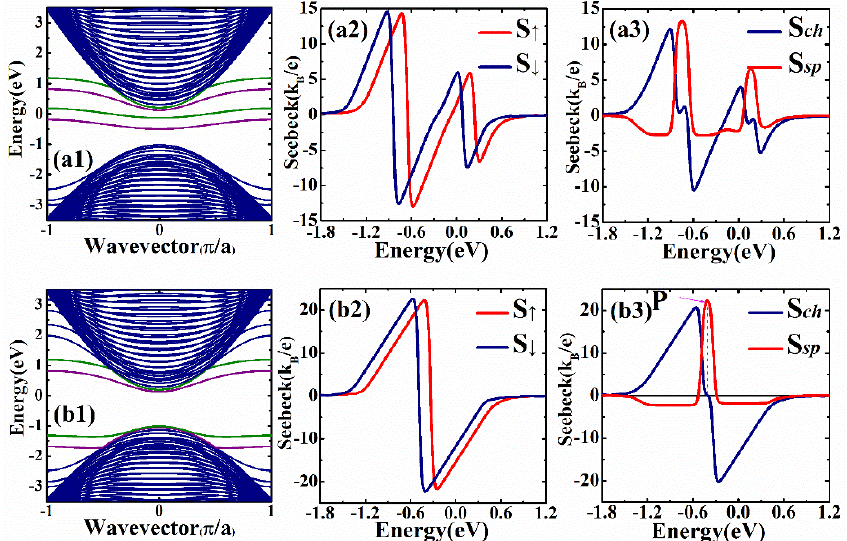
Figure 4. The band structures and spin-dependent Seebeck coefficients for the device with different voltages applied on the left and right edges of the ribbon. ( a1 – a3 ) The gate voltage is only applied on left edge with V g 1 = 1 eV and V g 2 = 0 eV. ( b1 – b3 ) The gate voltages are applied on both edges with V g 1 = 1 eV and V g 2 = − 1.5 eV. The other parameters for the device are: exchange splitting M = 0.184 eV and temperature k B T = 0.03 | t 1 |